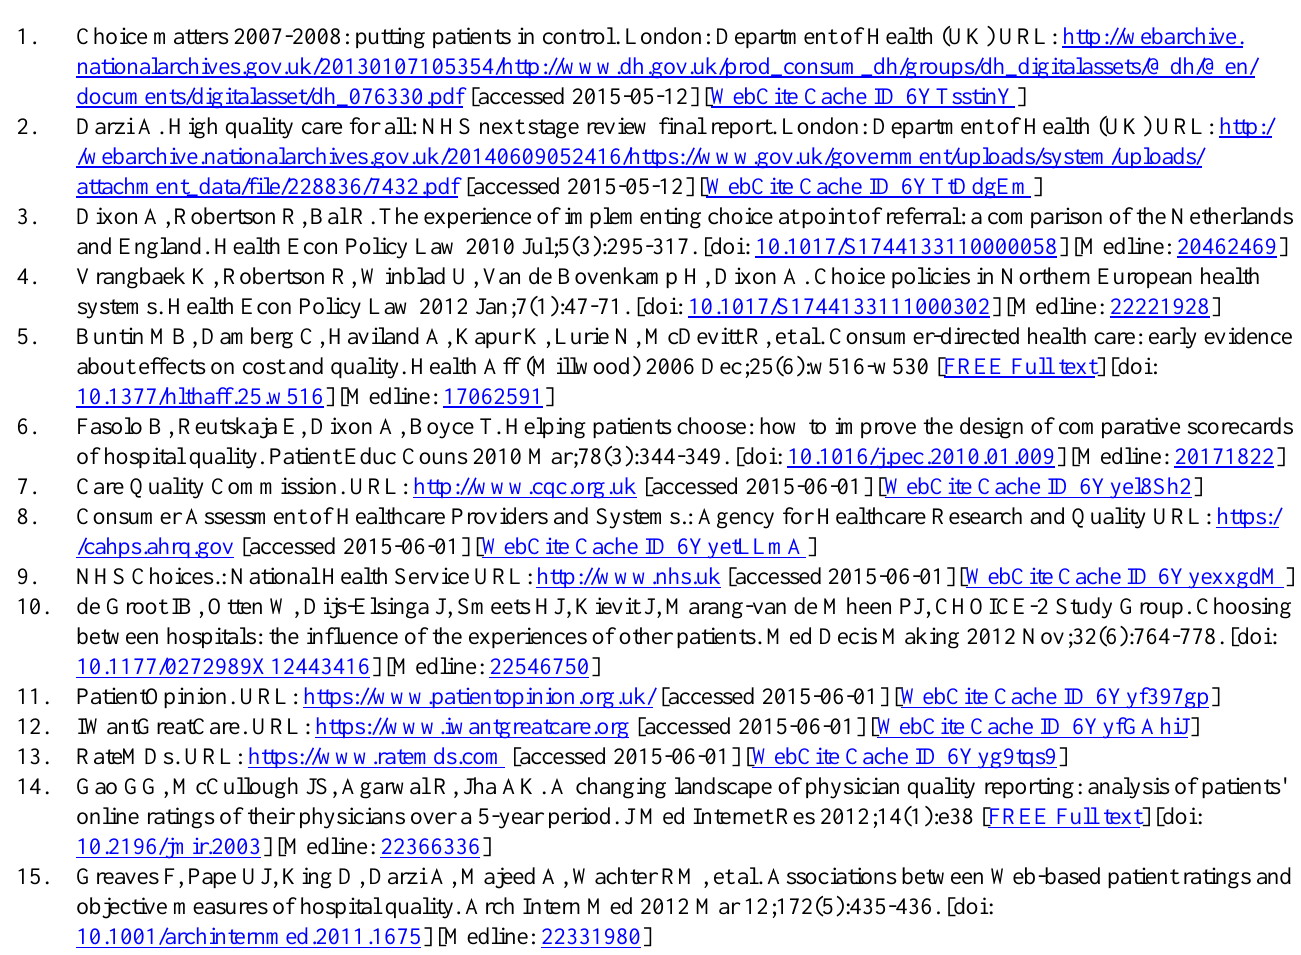
Tabulated P values of statistical comparison of mean rankings of quality indicators within and between